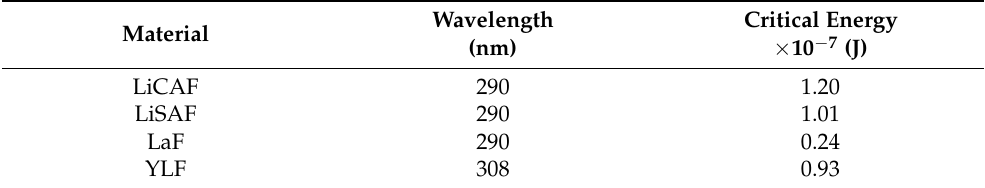
Figure 3. Critical energy, which defines the energy limit before self-focusing occurs, as a function of wavelength. Table 5. Peak laser emission wavelength and critical energy of the fluoride laser materials at their respective peak laser emission